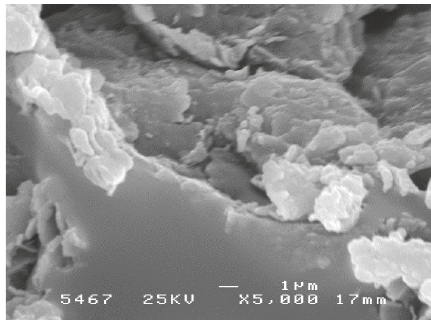
Figure 13: SEM image of treated soil surface at × 5,000 magnifica- tion.